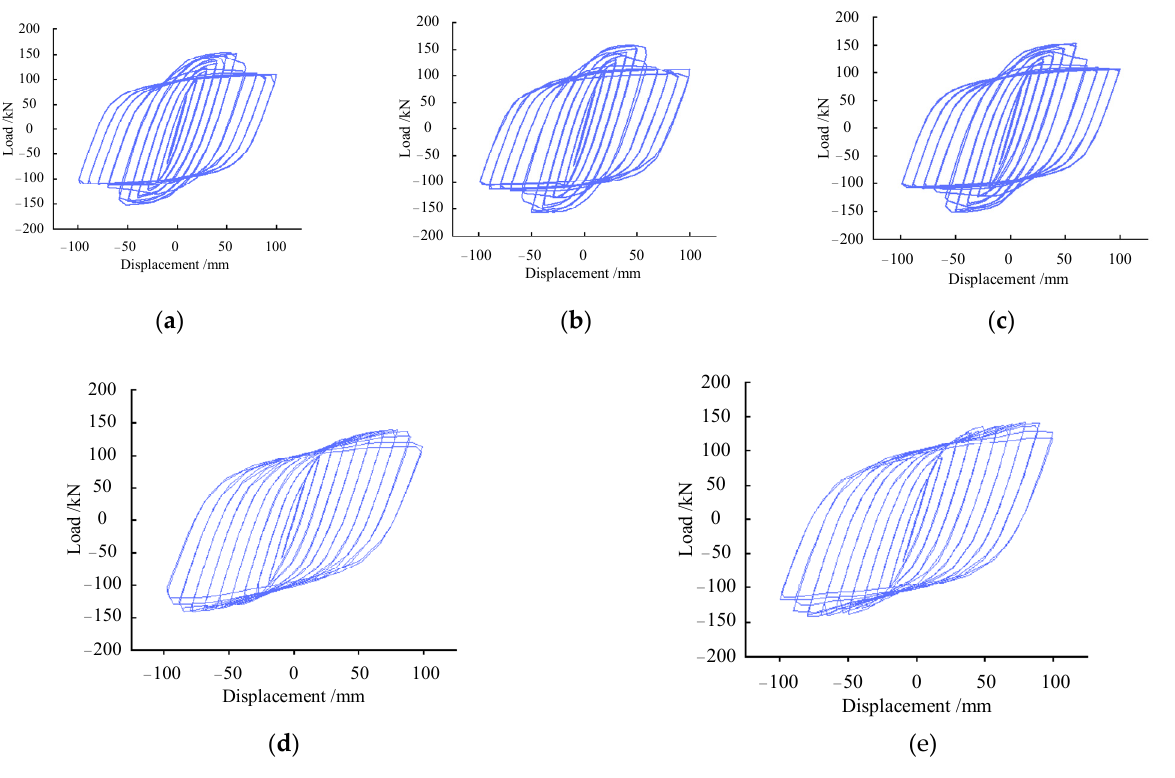
Figure 11. Joint hysteresis curve. ( a ) S ‐ 1; ( b ) S ‐ 2; ( c ) S ‐ 3; ( d ) S ‐ 4; ( e ) S ‐ 5.